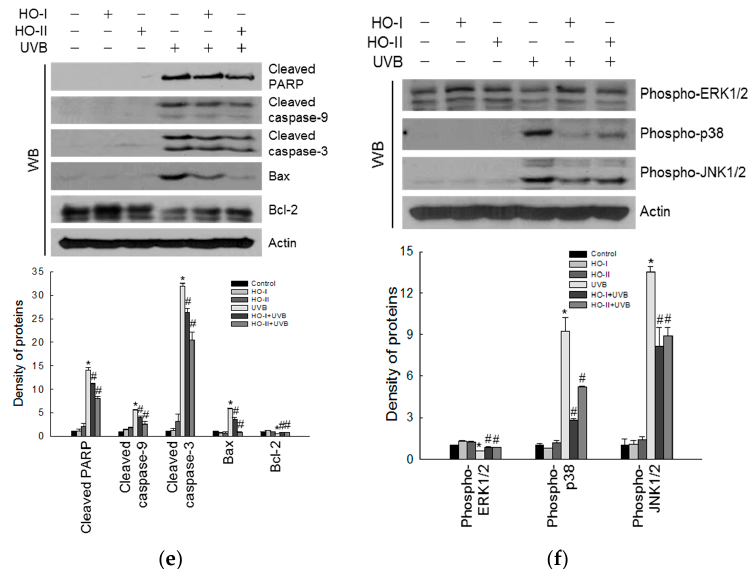
Figure 3. Horse oil attenuates UVB-induced apoptosis. HaCaT keratinocytes were treated with horse oil or NAC and exposed to UVB radiation 1 h later. Cells were then incubated for 24 h. Δψ m was analyzed by ( a ) confocal microscopy after staining the cells with JC-1 (Scale bar = 10 μ m). ( b ) DNA fragmentation was quantified by ELISA. ( c ) Apoptotic bodies (arrows) were observed in cells stained with Hoechst 33342 dye and quantified by fluorescence microscopy (Scale bar = 10 μ m). ( d ) Cell viability following UVB radiation was determined by MTT assay. ( e , f ) Western blotting with antibodies specific for ( e ) PARP, caspase-9, caspase-3, Bax, Bcl-2, actin, ( f ) phospho-ERK1/2, phospho-p38, and phospho-JNK1/2, and actin, and the results were quantified ( n = 3). * p < 0.05 vs. control, and # p < 0.05 vs. UVB-irradiated cells.